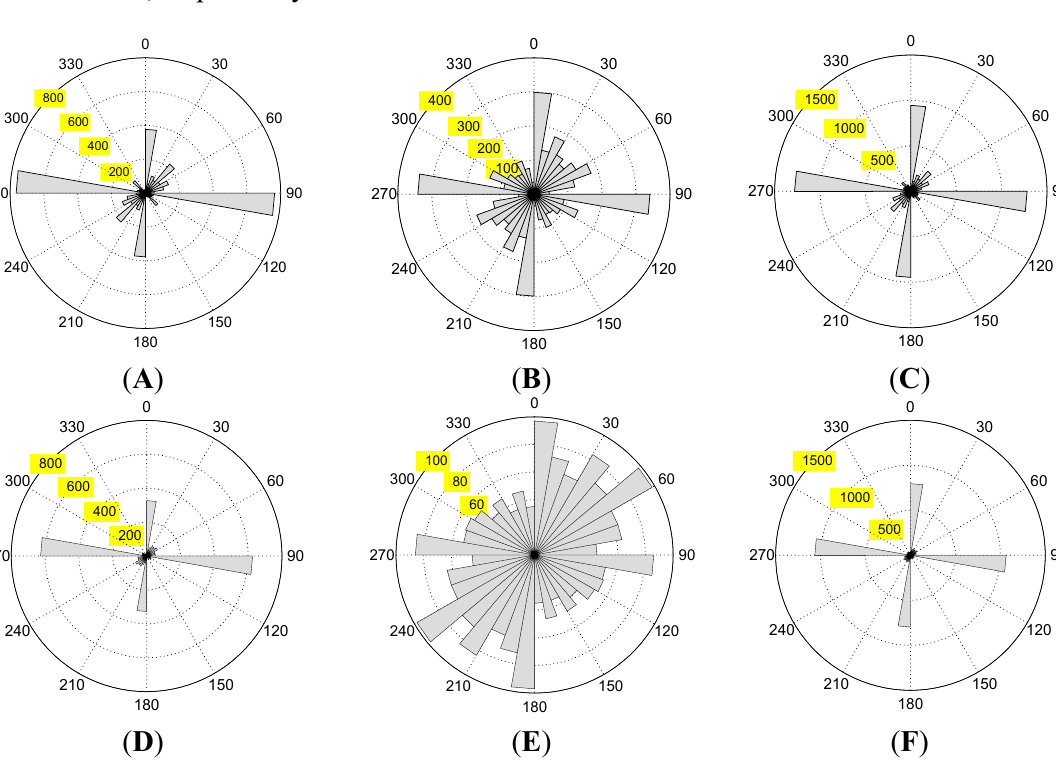
Figure 13. ( A – C ): Rose diagram for extracted line segments by Hough transform from binary edge maps produced by Sobel, LOG and Canny methods, respectively; ( D – F ): Rose diagrams for intermediate discontinuities map extracted using Tavares-Padilha algorithm from three data sources (Sobel, LOG and Canny); ( G – I ): Rose diagrams for final discontinuities map extracted using B-spline method from three data sources (Sobel, LOG and Canny). ( J ) and ( K ): Rose diagrams for manually and automatically (PCI) extracted discontinuities,